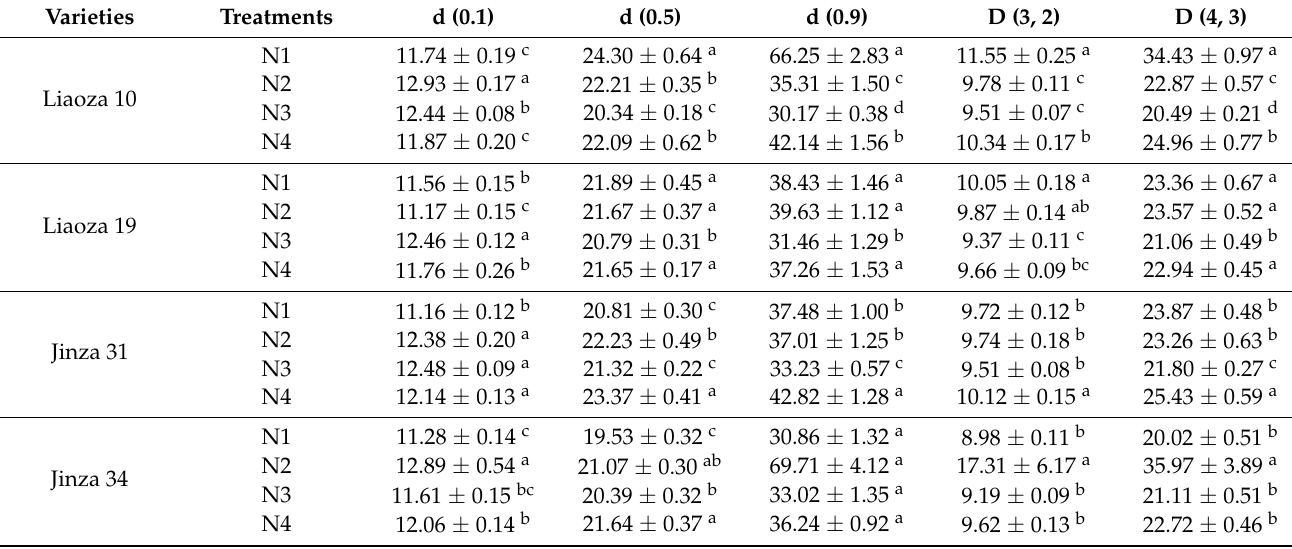
Table 1. Effect of nitrogenous fertilizer levels on sorghum starch morphology.